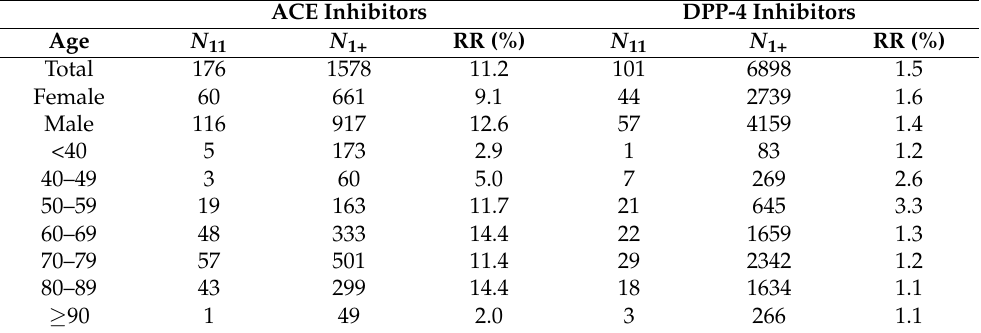
Table 2. Characteristics of patients using ACE inhibitors/DPP-4 inhibitors and their distribution by sex and age.